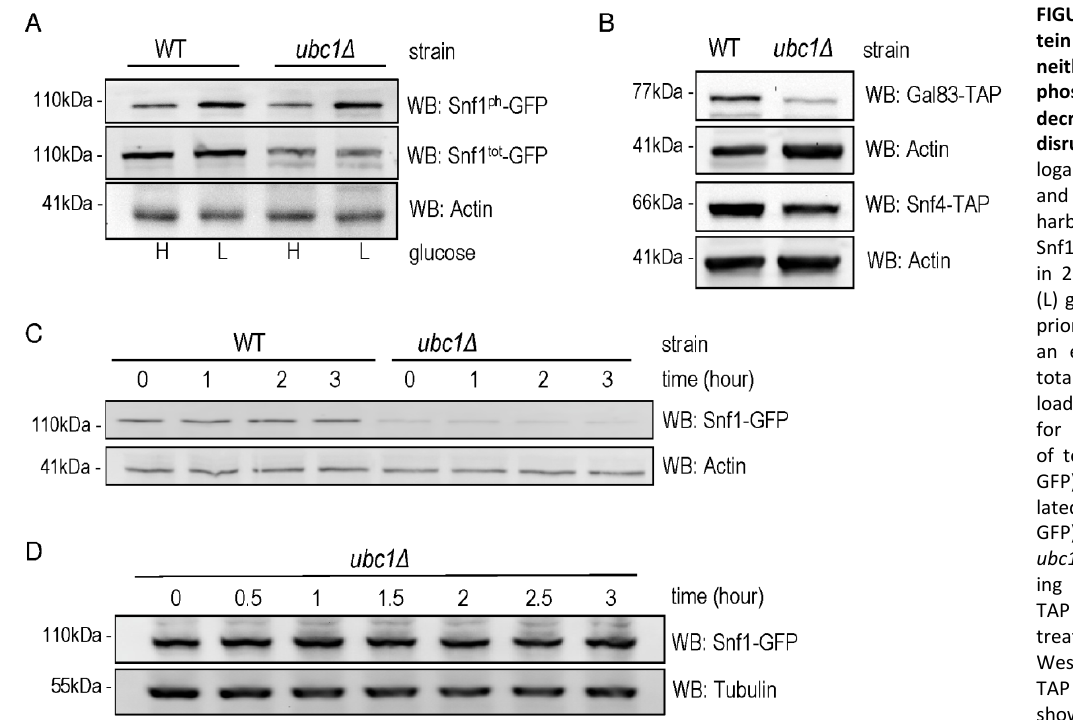
treated as in (A) and Western analysis for TAP abundance is shown. (C) Assess- ment of Snf1